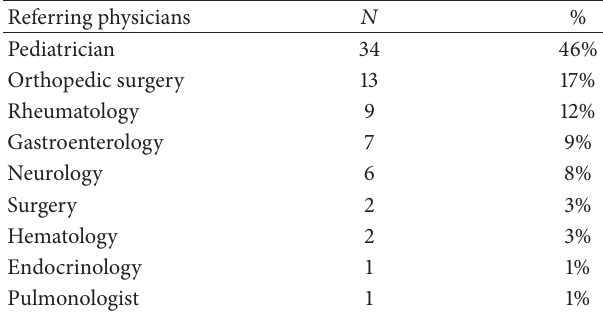
Table 3: List of referring physicians by specialties.